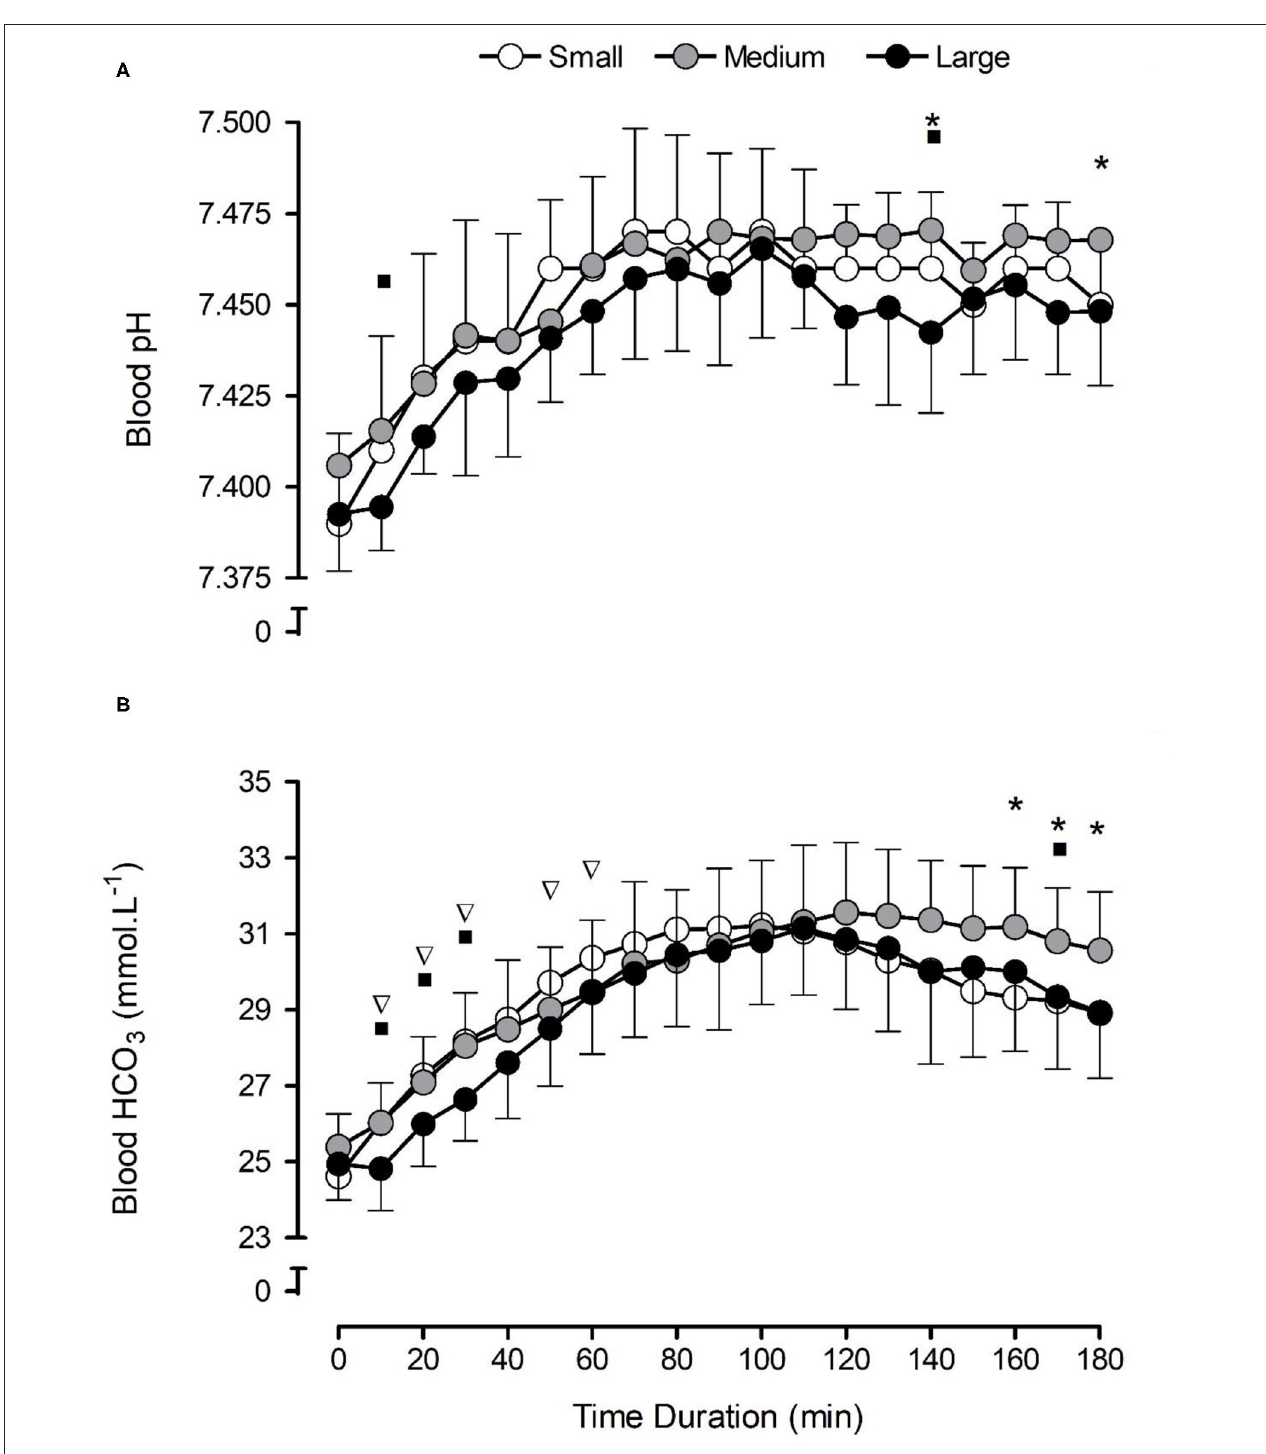
FIGURE 1 | Mean ( ± SD) temporal blood pH (A) and bicarbonate concentration [HCO − 3 ] (B) responses following the consumption of 0.3 g · kg − 1 body mass NaHCO 3 in small-, medium-, and large-sized capsules. *a condition × time interaction between small and medium capsules, where p < 0.05. ∇ a condition × time interaction between small and large capsules, where p < 0.05. (cid:4) a condition × time interaction between medium and large capsules, where p < 0.05.